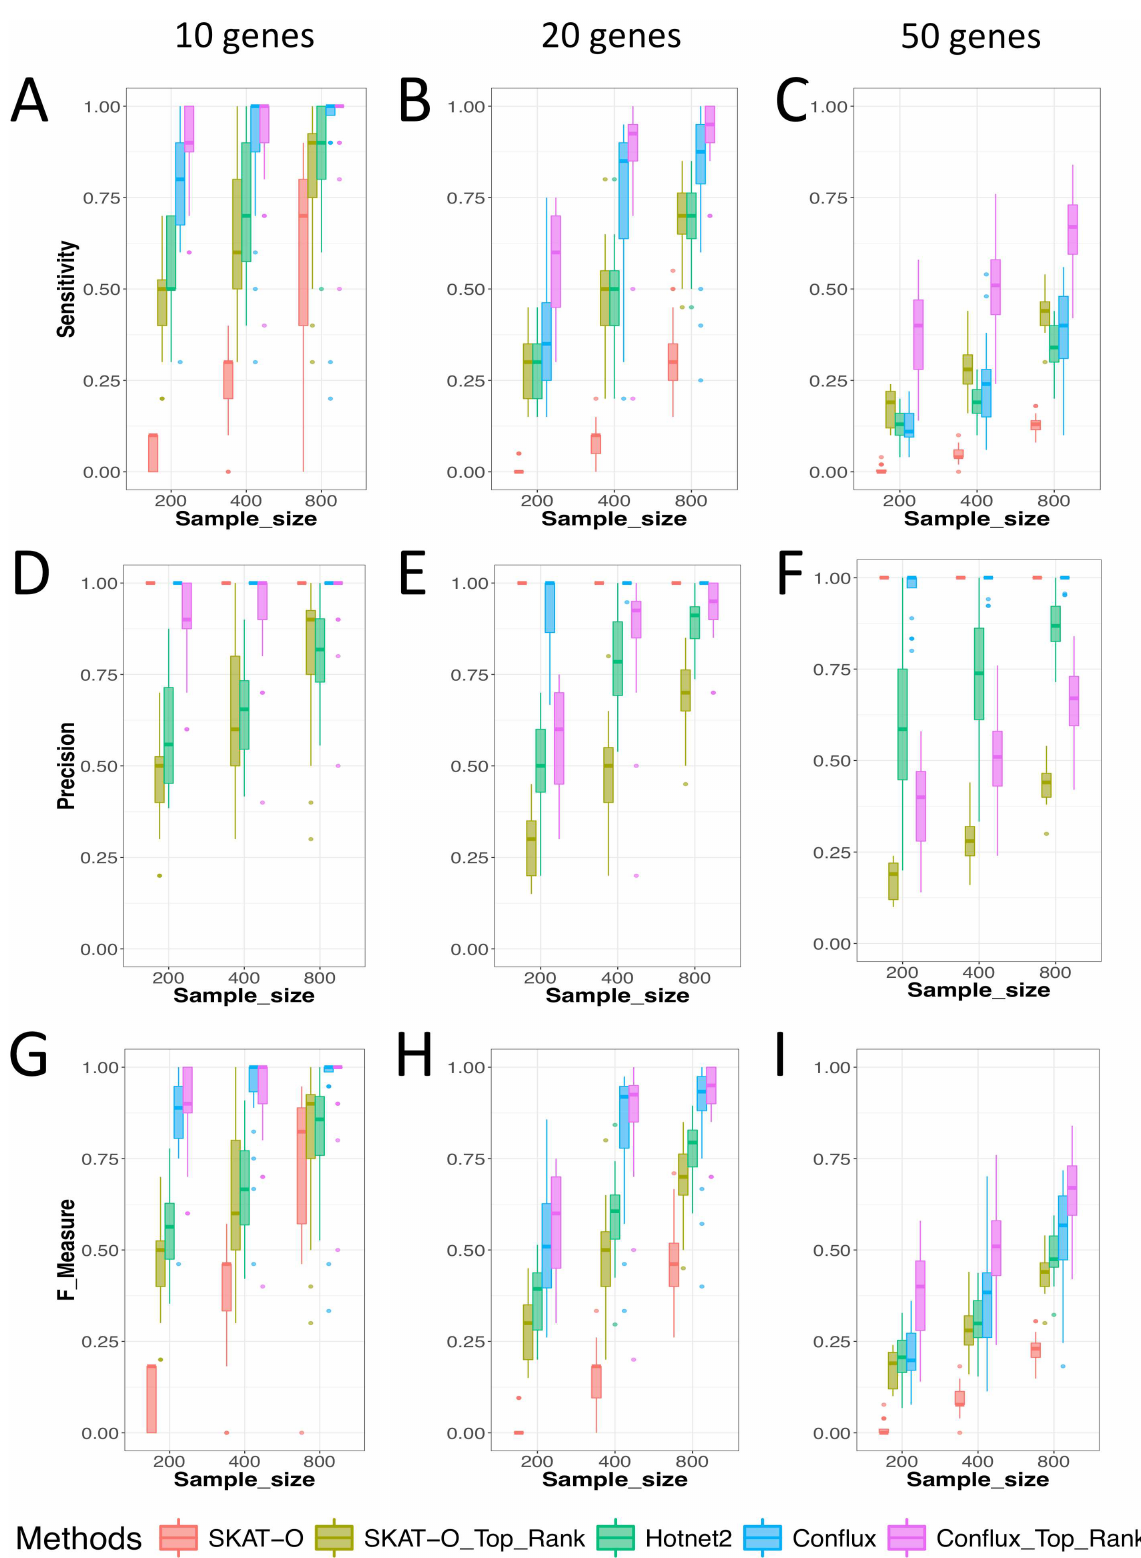
Fig 1. Sensitivity (A-C), precision (D-F) and F-Measure (G-I) as a function of the complexity of the disease (the number of selected causal genes), evaluated for our method (Conflux), SKAT-O and Hotnet2. The columnsrepresent increasing